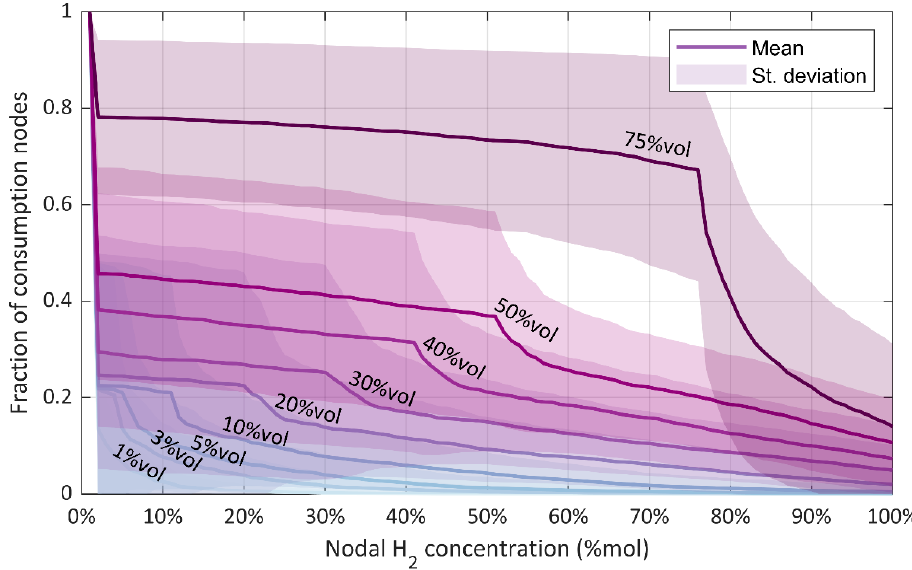
Figure 7. Distribution of H 2 concentrations received by consumption nodes: fraction of load nodes for which the received H 2 molar concentration exceeds a given value—pure H 2 injected within the network.